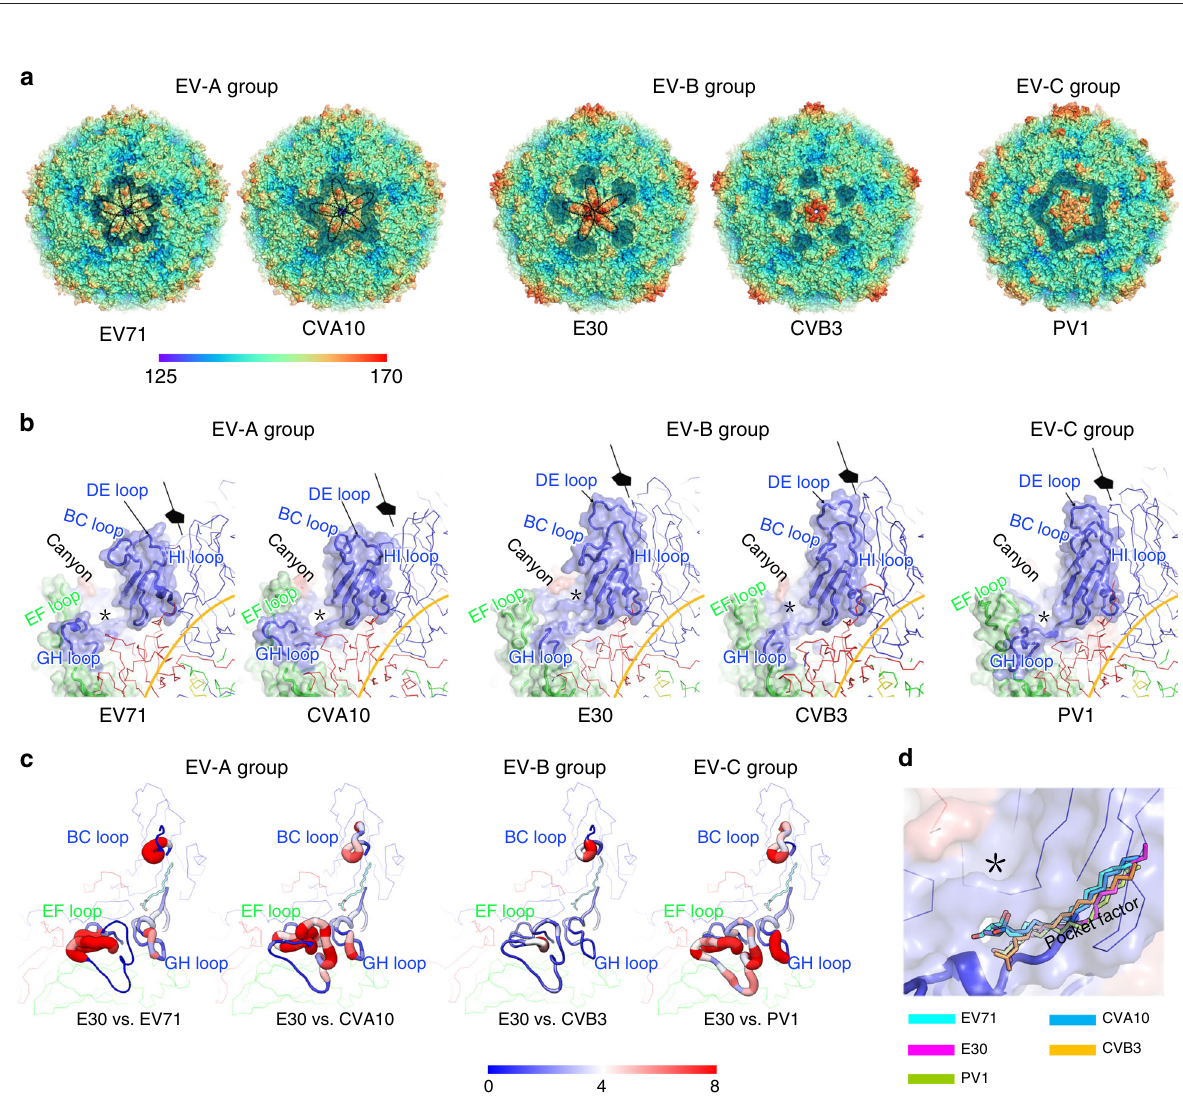
Fig. 1 Cryo-EM structures of E30 F-, E-, and A-particle. a Surface representation of E30 F-, E-, and A-particle along the icosahedral twofold axes. The surfaces are rainbow-colored by radius from blue through yellow, green, and indigo to red, which correspond to 120, 135, 145, 155, and 165 nm, respectively. One icosahedral asymmetric unit is marked with a black triangle in E30 F-particle and icosahedral symmetry axes are drawn in black. The obstructed off- axis channels near the twofold axes in A particle are highlighted in magenta. b Thin slices of the central sections of each particle in a; they were colored with the same color scheme. c Cartoon representation of the E30 F-particle perceived from the twofold axes (left). A single icosahedral protomer is zoomed in, shown as line and accentuated in inset (right). The signature colors (VP1, blue; VP2, green; VP3, red; VP4, yellow) were applied to each subunit. d Electron density maps from a section of VP1, VP2, VP3, and VP4, respectively. e Protomeric units shown with respect to the icosahedral axes of the particles by superposing whole particles. The F-, A-, and E-particle were colored in signature color, wheat and gray, respectively as the color bars below display. f Protomeric superpositions of F- and A-particle (left), as well as F- and E- particle (right). Structural differences are mapped onto the protomer of the full particle; the thickness and color of the worm representation re fl ect the local deviation between the structures [from blue (0 Å) to red (8 Å)]. Regions missing in the A- or E-particle are shown in green (VP4 is omitted).